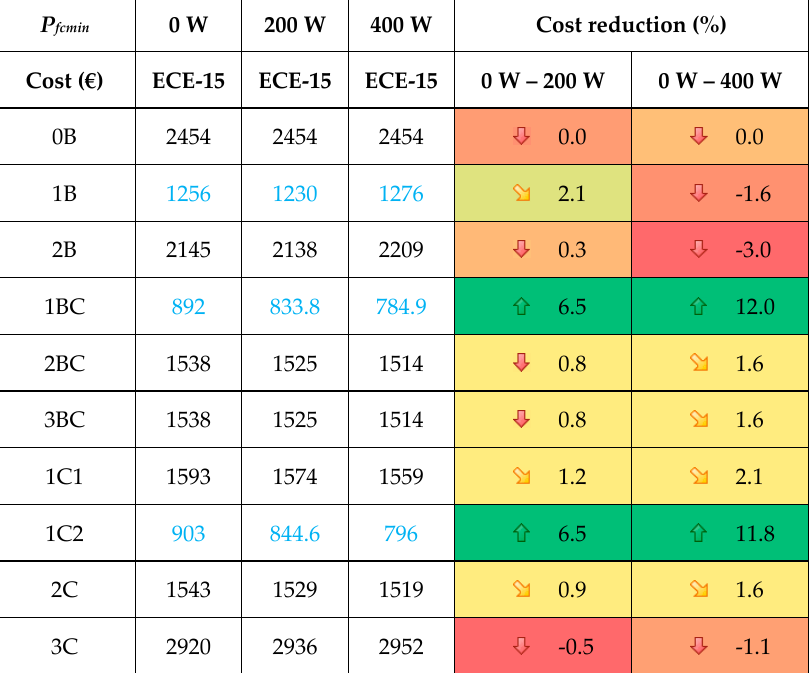
Table 5. Influence of the fuel cell minimum power on PDS cost for the ECE-15 profile.